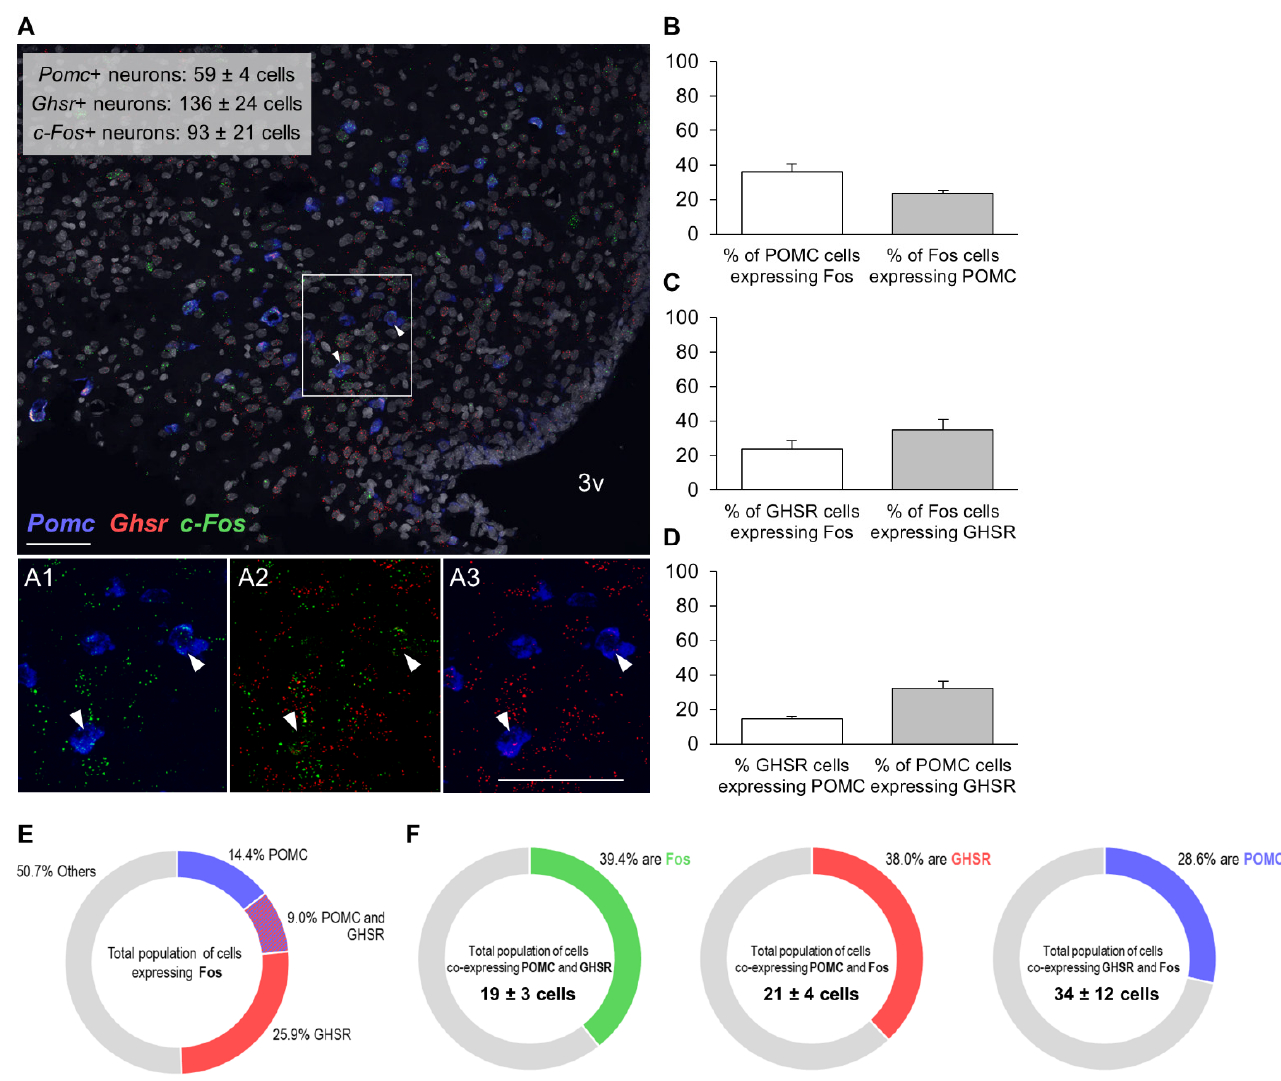
Figure 5. Colocalization of mRNAs for Fos protein, GHSR and POMC in the Arc of non-food-deprived PB taste-familiar rats exposed to the olfactory PB cue. ( A ) Representative confocal images of triple RNAscope in situ hybridization for c-Fos (green), Ghsr (red) and Pomc (blue) in an Arc-containing section of a PB taste-familiar rat exposed to the olfactory PB cue. Area in the white rectangle is shown enlarged in the small panels on the right ( A1 – A3 ); colocalization of mRNAs for ( A1 ) Fos protein and POMC; ( A2 ) Fos protein and GHSR; and ( A3 ) GHSR and POMC. White arrows indicate triple positive cells. The graphs depict ( B ) % of POMC cells that are Fos+, and the % of Fos cells that are POMC+; ( C ) % of GHSR cells that are Fos+, and the % of Fos cells that are GHSR+; ( D ) % of GHSR cells that are POMC+, and the % of POMC cells that are GHSR+ (Data are represented as mean ± SEM). ( E ) Overview of the molecular identities of Fos+ cells; ( F ) triple colocalization data. 3v, third ventricle. Bregma: − 3.48 mm; Scale bar = 50 μ m (applies to all four images). Three–four hemisections per rat were quantified ( n = 3).